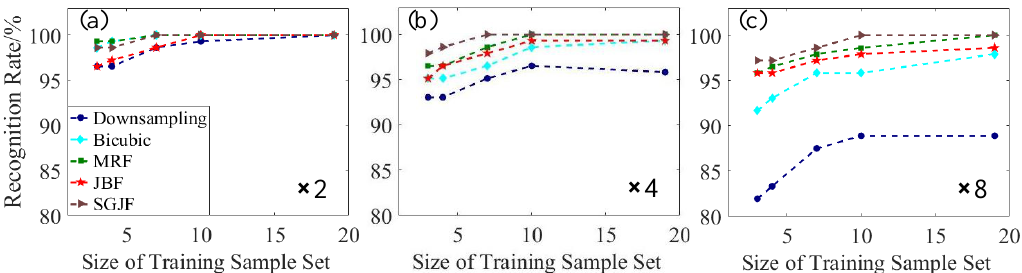
Figure 6. Comparison of recognition rates of different SR algorithms and factors without noise. ( a ) 𝑑 = 𝑠 = 2 . ( b ) 𝑑 = 𝑠 = 4 . ( c ) 𝑑 = 𝑠 = 8 .